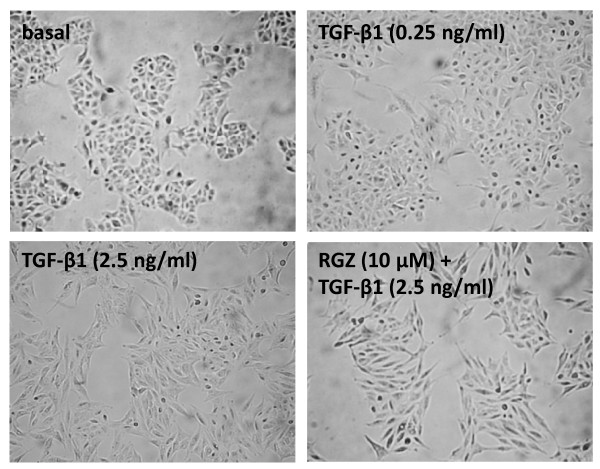
Regulation of TGF-β1-induced changes in cell morphology by rosiglitazone. A549 cells were incubated with vehicle (0.1% DMSO), TGF-β1 (0.25 ng/ml), TGF-β1 (2.5 ng/ml) or TGF-β1 (2.5 ng/ml) + RGZ (10 μM) for 72 hr and photographed at 100× magnification. The images are representative of 4 separate experiments.